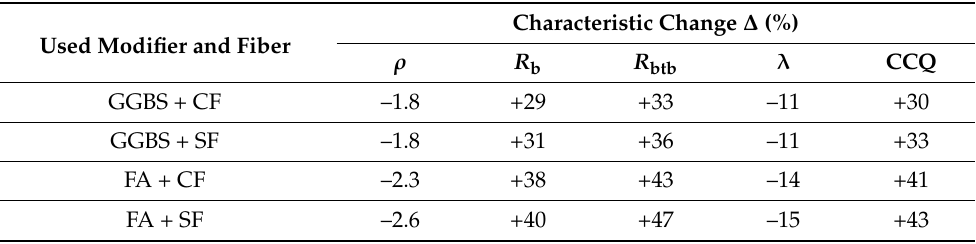
Table 15. Improvement of the physical and mechanical characteristics of aerated concrete due to modification with mineral additives and dispersed reinforcement with fibers of plant